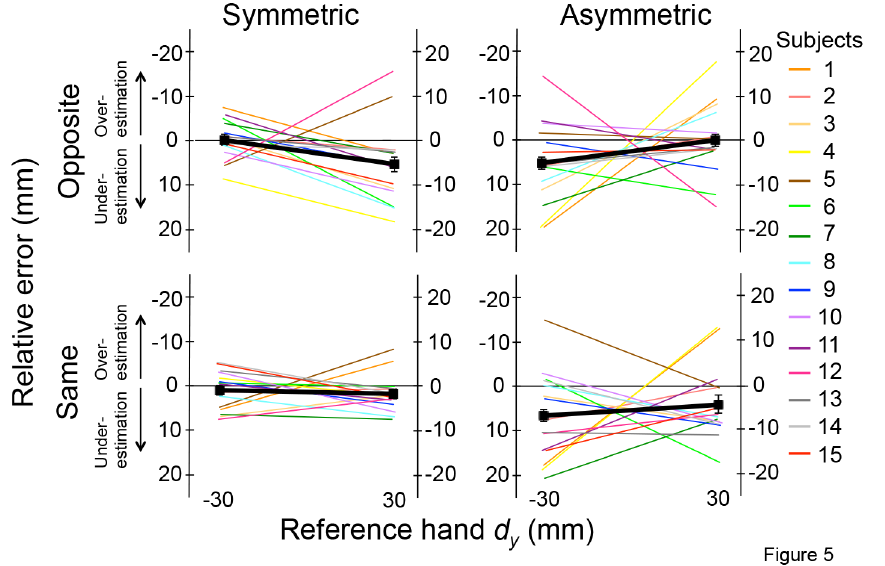
Figure 5. Relative error: individual subjects. Averages of relative errors of 5 trials from each subject are shown as a function of reference hand d y ( 2 30 and + 30 mm) for each of the four matching conditions. The thick black line denotes the mean relative error averaged across 15 subjects with standard error of the mean. Data from the collinear condition were excluded (see text for more details). The left- and right-hand y -axes for each plot refer to relative errors obtained for reference hand d y of 2 30 and 30 mm, respectively, in which positive or negative relative error are defined as under-estimation errors,